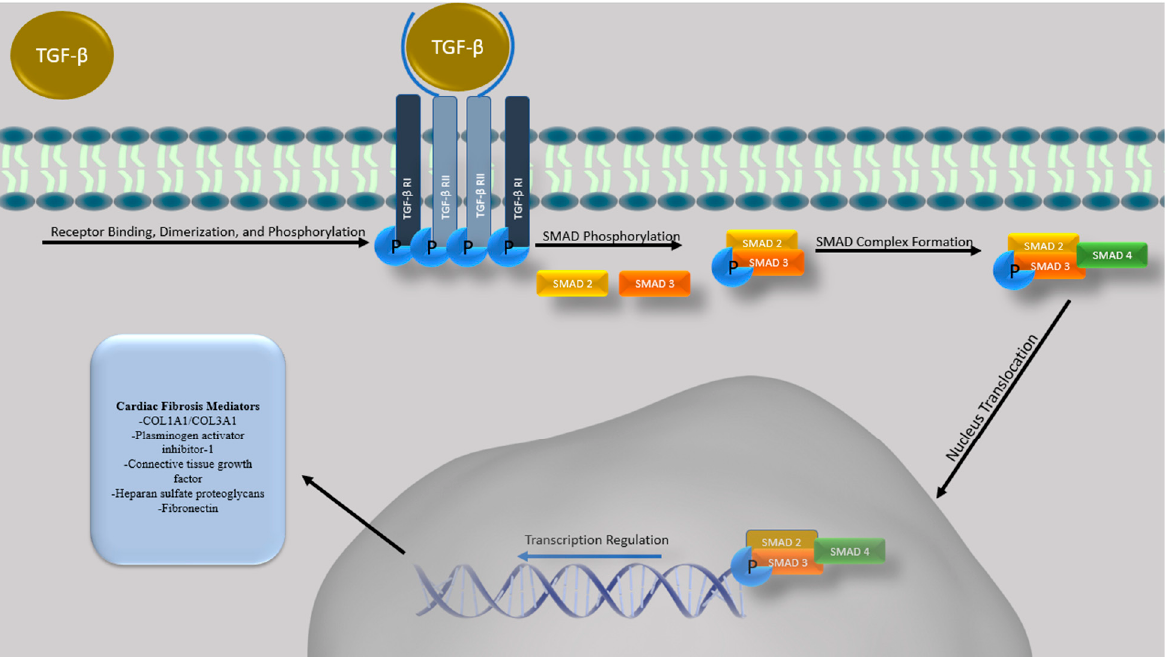
Figure 1. Overview of Conventional TGF- β Signaling. A schematic overview of conventional (SMAD-mediated) TGF- β signaling occurring after TGF- β ligand binding which leads to the activation of TGF- β type I and TGF- β type II receptor heteromeric complexes which can induce the phosphorylation of SMAD2 and 3, promoting complex formation with co-SMAD (SMAD4). This trimeric complex can translocate into the nucleus and induce the transcription of numerous genes, including those involved in cardiac remodeling and fibrosis, as well as cellular differentiation, survival, invasion and apoptosis.